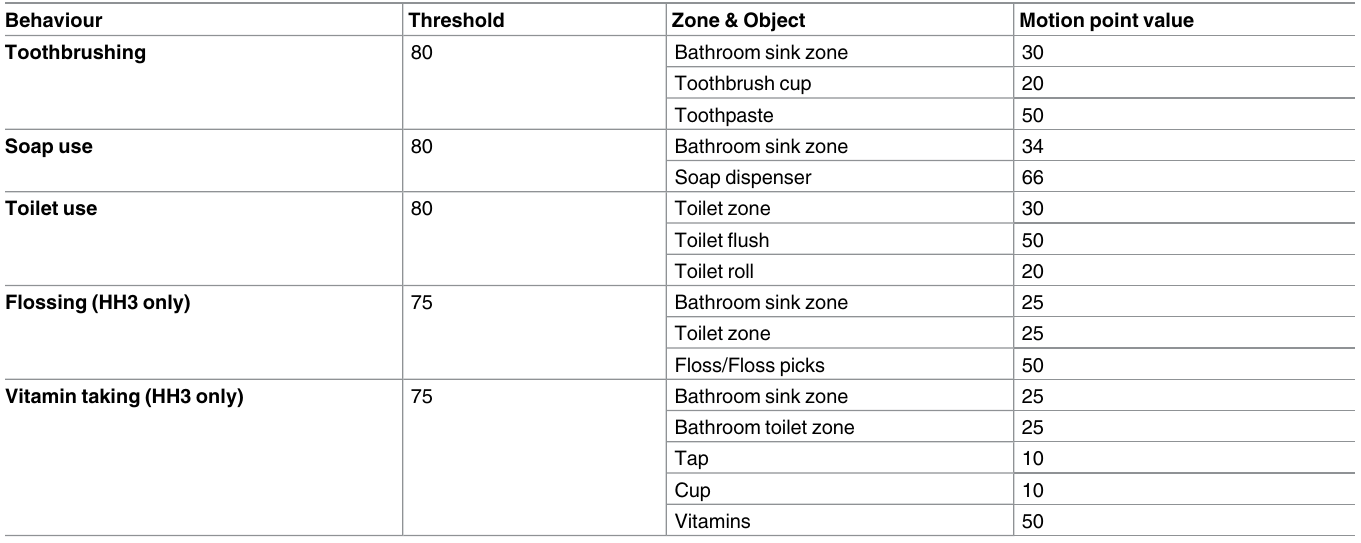
Table 3. Parametervalues for each behaviour within the activity